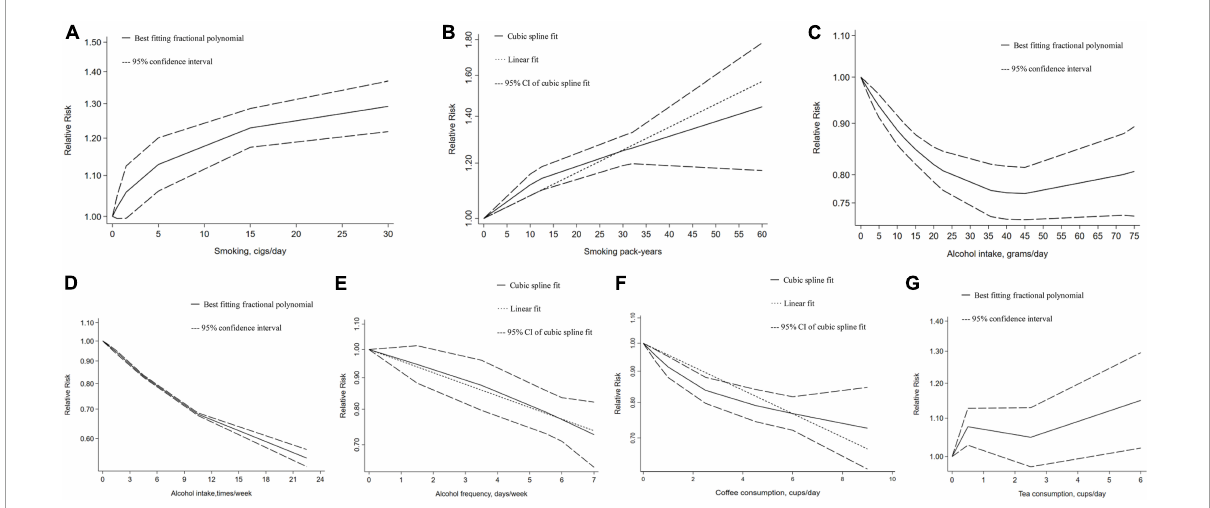
FIGURE1 Dose–response relationship between addictive substance intake and the gallstone risk. (A) Smoking cigarettes per day, (B) smoking pack-years, (C) alcohol intake grams per day, (D) alcohol intake times per week, (E) alcohol drinking days per week, (F) coffee consumption cups per day, (G) tea consumption cups per day. Two-term best fitting fractional polynomial regression model indicated that a potential non-linear model fitting the observed outcomes is identified. A single cubic spline curve is fitted to the data and the goodness of non-linear fit is calculated. Since the non-linear fit was not significant and it was similar to the linear fit model, so linear regression is used.